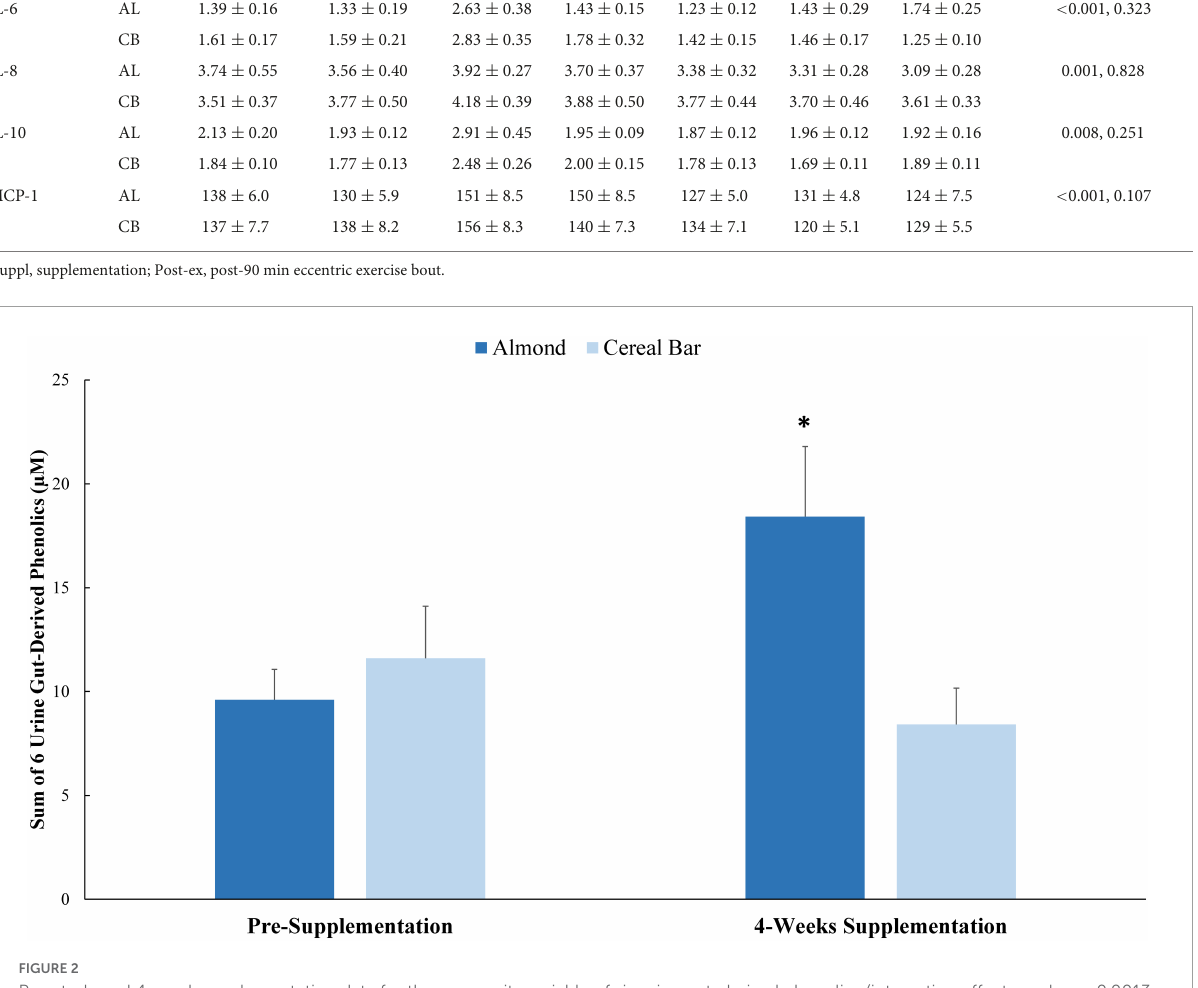
hydrolyzed by the soluble epoxide hydrolase enzyme (sEH)